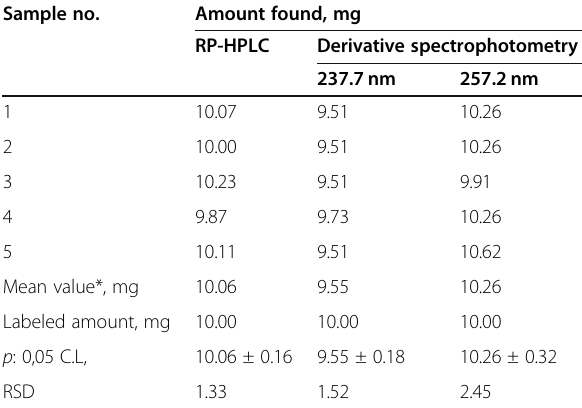
Table 3 Linearity and regression values for proposed methods Method